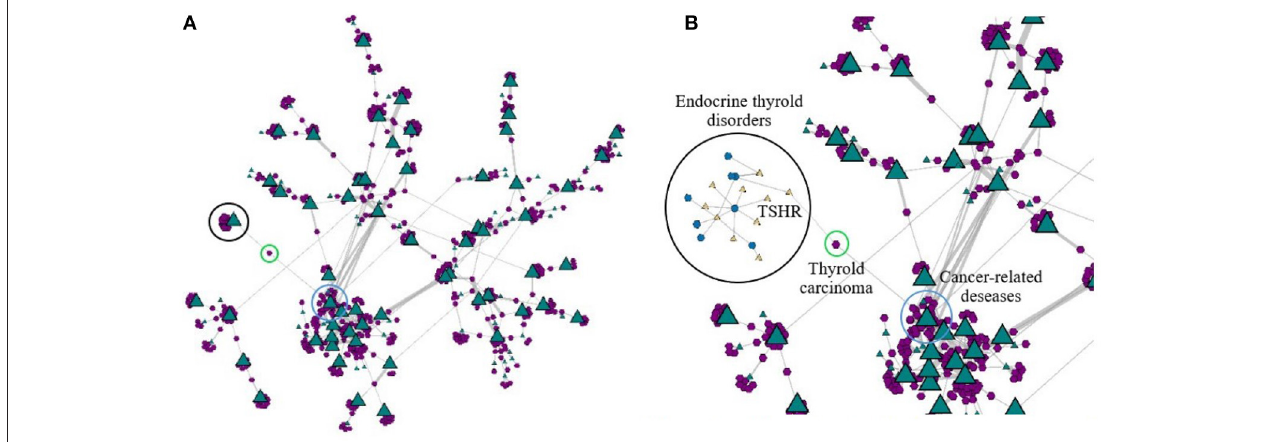
FIGURE 9 | An exploratory investigation conducted over the network after coarsening the gene layer (represented by the green triangles) only: panel (A) depicts the coarsened gene layer; panel (B) depicts the local expansion of the super-nodes enclosed in the black circle in (A) .